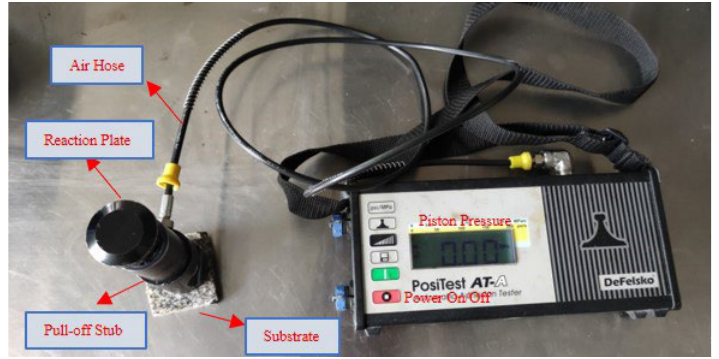
Figure 4. ASTM D 4541 Type IV adhesion tester.